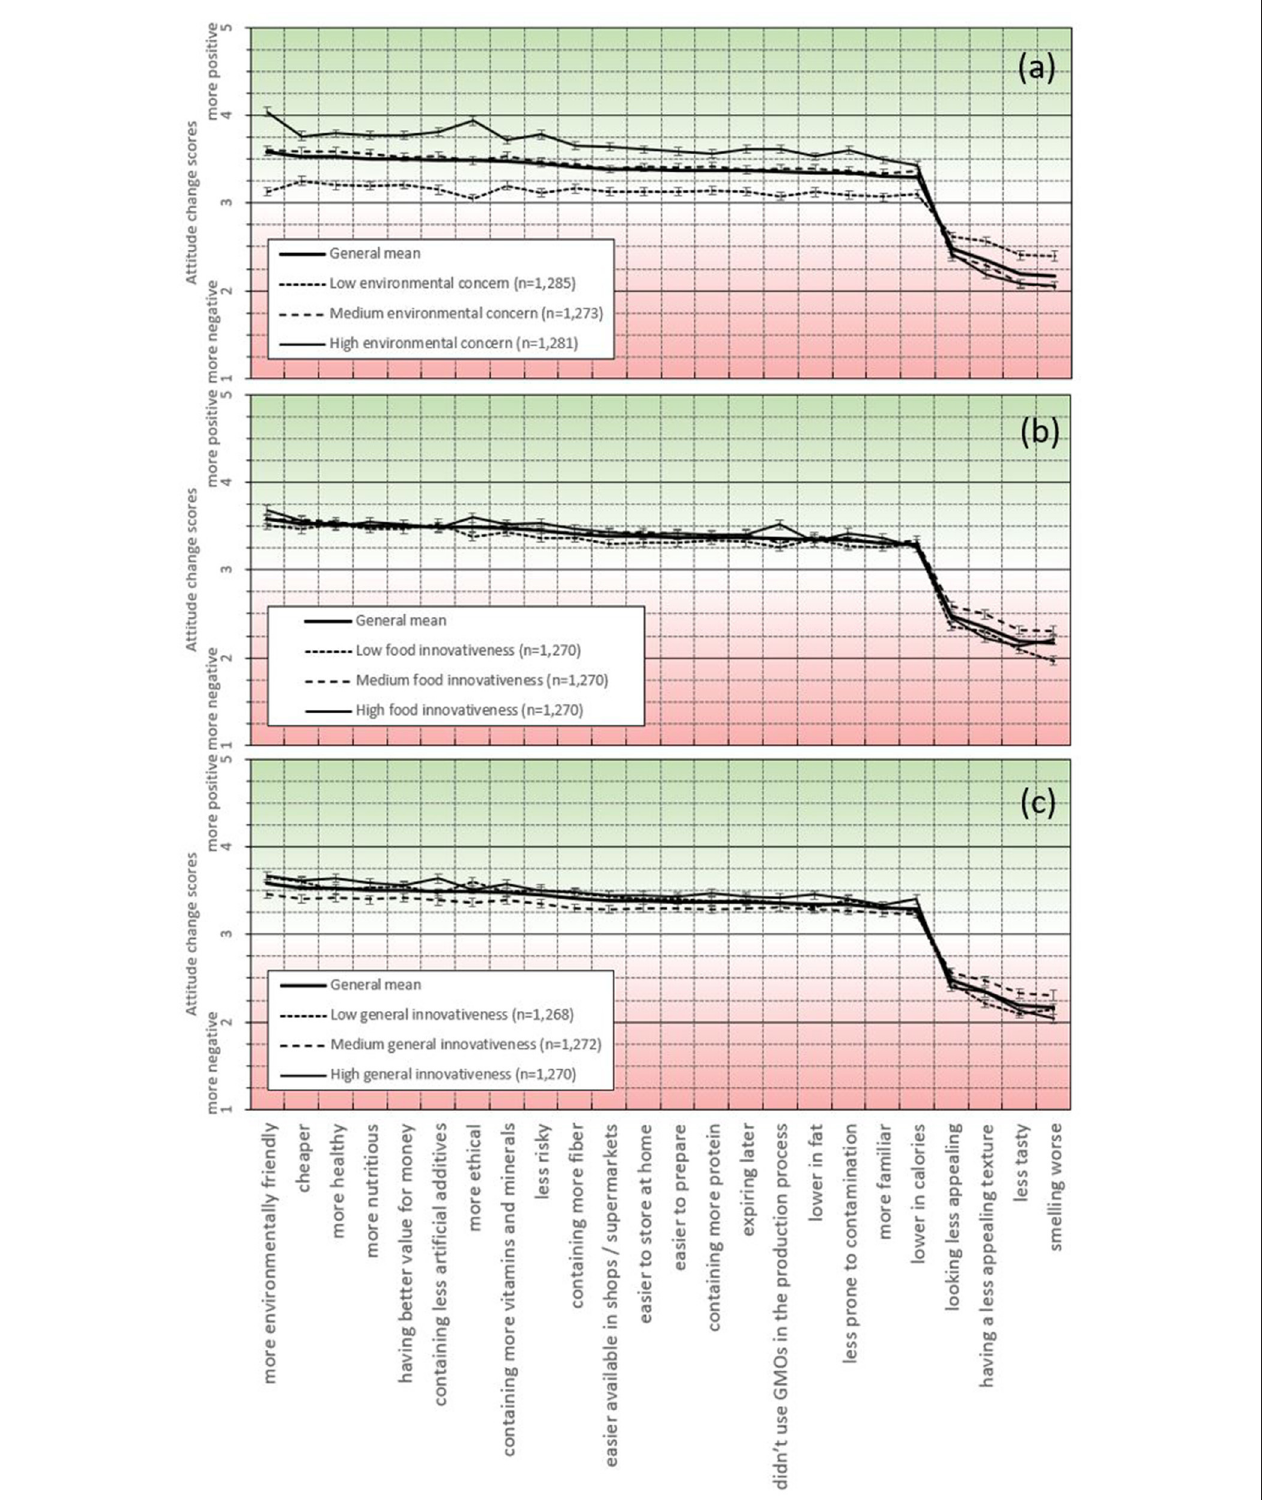
FIGURE 6 | Differences between NEP levels (a) , food innovativeness (b) , and general innovativeness (c) . The error bars represent 95% credibility intervals estimated with Bayesian estimation.